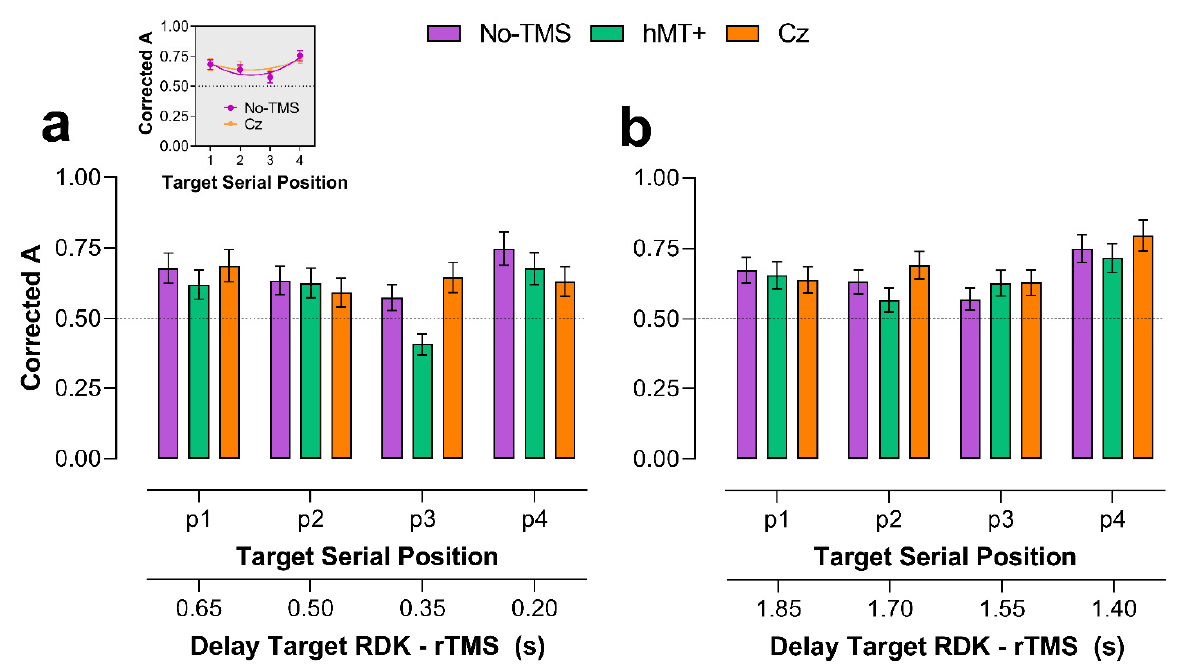
Figure 2. Mean A values for each serial position of the target RDK (1 to 4) and each TMS condition (i.e., No-TMS, and rTMS over hMT+ and Cz). The plotted data and error bars were estimates from the output of the selected models for early and late rTMS. The horizontal dashed lines indicate the chance level ( A = 0.5). The secondary x-axes indicate the time delay (in seconds) between the offset of the target RDK in the motion sequence and the onset of the rTMS. ( a ) Mean A values estimated for early rTMS (i.e., 0.2 s after the offset of the motion sequence). In this case, for target in position 1, rTMS was delivered after 0.65 s from the offset of the first RDK. The insert above panel (a) shows the quadratic fit to the A values of the No-TMS and Cz conditions (averaged over the early and late rTMS conditions) of the form: y = b 0 + b 1 x + b 2 x 2 , where b 0, b 1, b 2 are the coefficients of the polynomial function. No-TMS: b 0 = 0.90, b 1 = − 0.26, b 2 = 0.06, R 2 = 0.8, SS = 0.003; Cz: b 0 = 0.80, b 1 = − 0.14, b 2 = 0.03, R 2 = 0.75, SS = 0.0014. ( b ) Mean A values estimated for late rTMS (i.e., 1.4 s after the offset of the motion sequence). Error bars ±